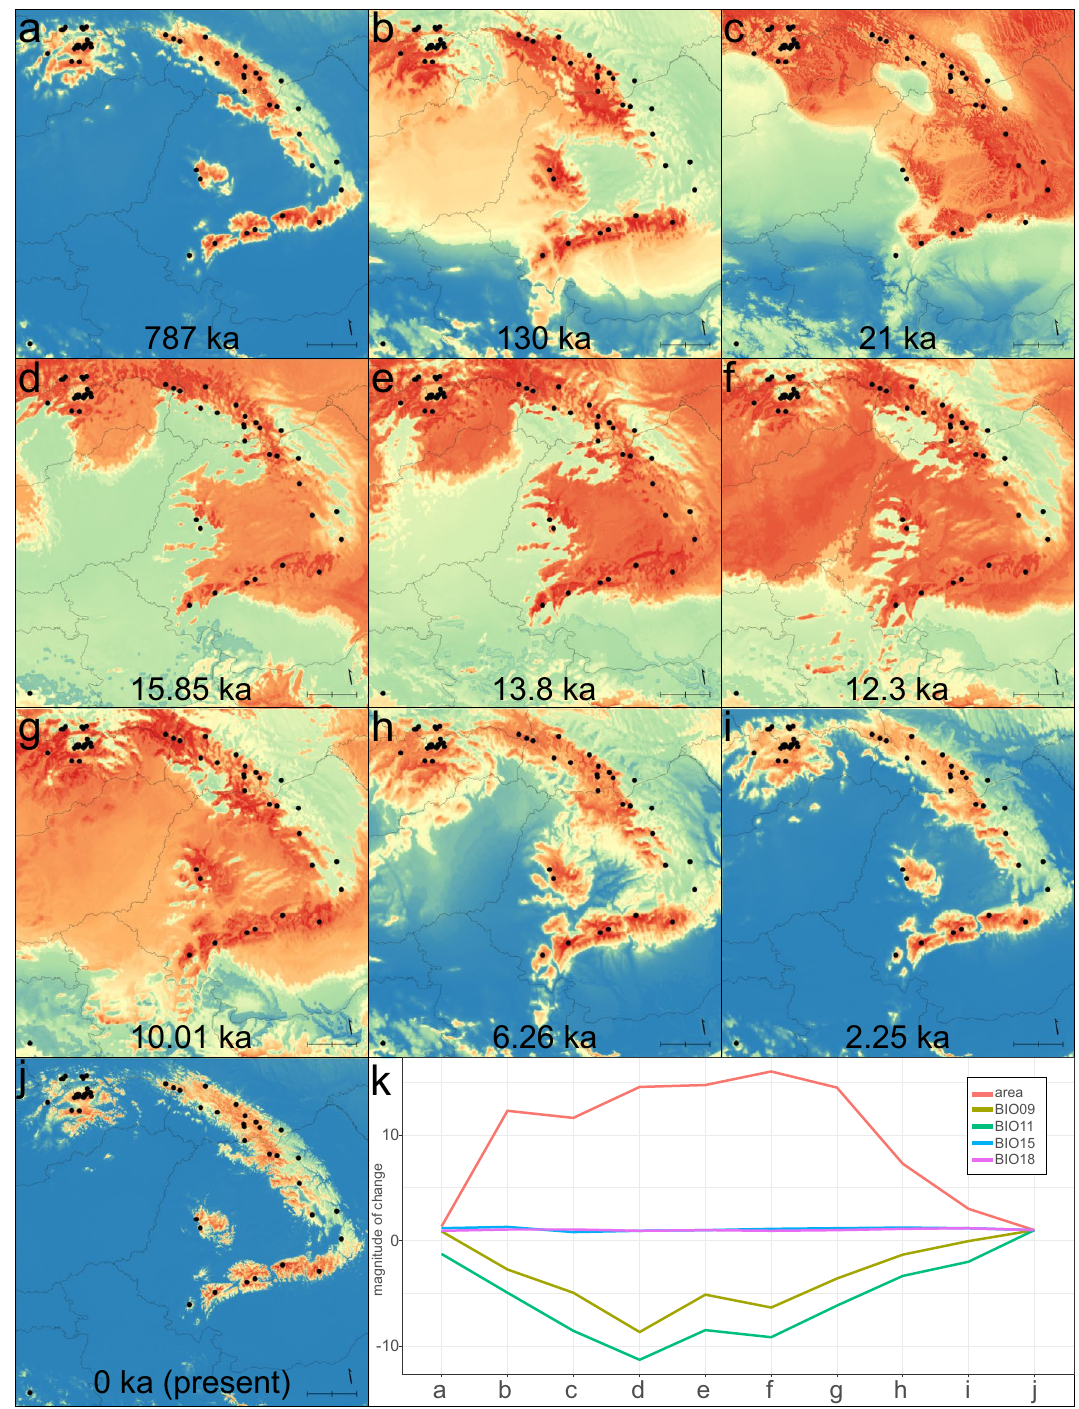
Figure 5. Potential distribution of L. rotundifolium throughout the Pleistocene epoch determined by five niche modeling algorithms (MAXENT, BRT, BART, CTA, and ANN) summarized by their first principal component axis. Warmer colors indicate higher suitability, while blue indicates unsuitable areas. ( a ) MIS 19 interglaciation ca. 787 ka; ( b ) last interglacial ca. 130 ka; ( c ) last glacial maximum ca. 21 ka; ( d ) Heinrich Stadial 1 17.0–14.7 ka; ( e ) Bølling- Allerød 14.7–12.9 ka; ( f ) Younger Dryas Stadial 12.9–11.7 ka; ( g ) Greenlandian 11.7–8.326 ka; ( h ) Northgrippian 8.326–4.2 ka; ( i ) Meghalayan 4.2–0.3 ka; ( j ) the Anthropocene, 1979–2013; and ( k ) trends in variables used in the modeling displayed as a mean across the map area, with x-axis labels corresponding to the facets of the figure. BIO09 = mean temperature of the driest quarter; BIO11 = mean temperature of the coldest quarter; BIO15 = seasonality of precipitation; BIO18 = precipitation of warmest quarter; and “area” corresponds to the number of pixels with suitability greater than 30%. The y-axis shows the magnitude of the change, where 1 is the value given for the present conditions. The scale bar in the bottom right corner of each map is equivalent to 100 km. The maps are projected using ETRS 89 (EPSG: 3035). Sampled populations used in this study are shown as black circles to indicate their present distributions. The maps are drawn using R ver. 3.6.2 76 and QGIS ver. 3.8 77